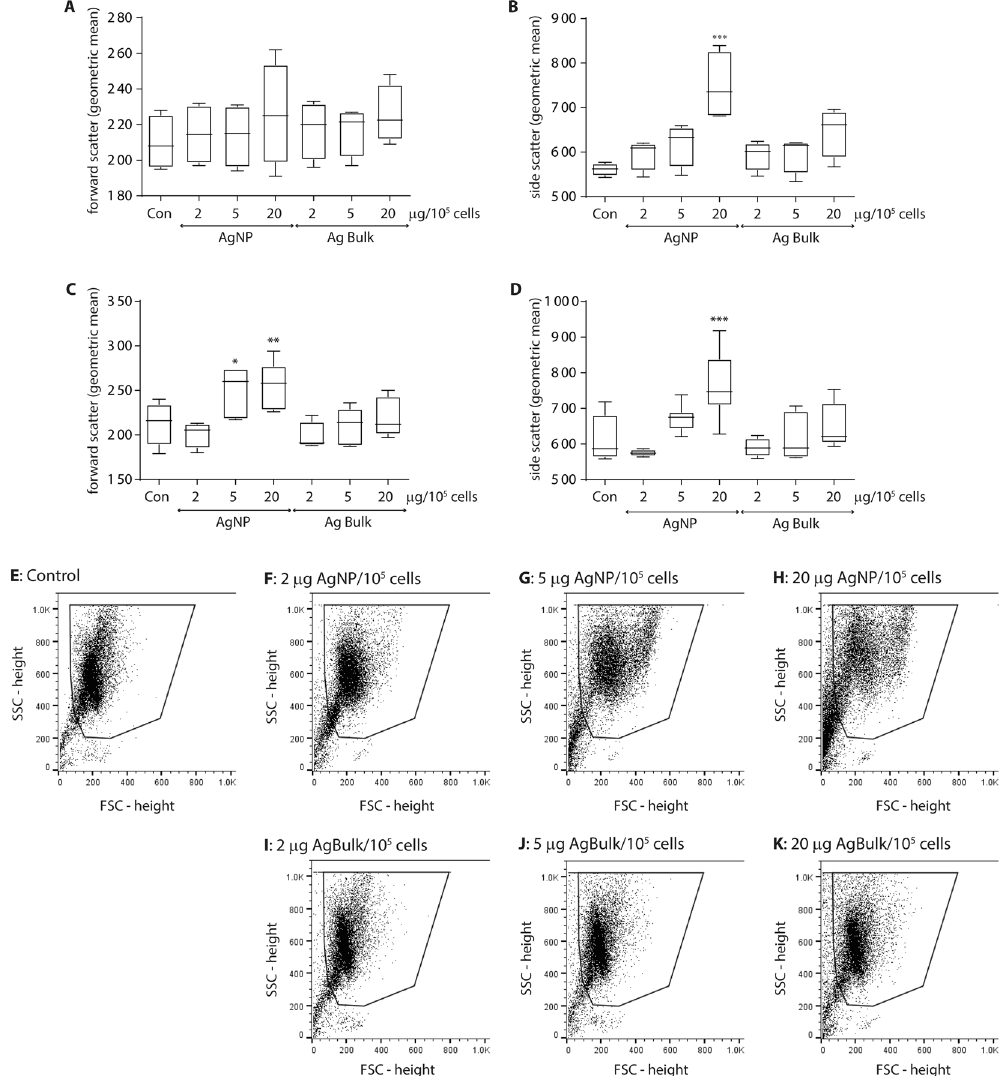
Figure 1. Exposure to silver nanoparticles increases human neutrophil size and granularity. Human neutrophils were exposed to 2, 5 or 20 µ g silver nanoparticles (AgNP) or bulk particles (Ag Bulk) per 10 5 cells at 37 °C and analysed by flow cytometry analysis, counting 10000 gated events. Neutrophil forward ( A and C ) and side scattering ( B and D ) after 4 hr ( A and B ) and 20 hr ( C and D ) was quantified. Plots present the maximum and minimum geometric mean for n > 4 preparations; the median size is indicated by the horizontal